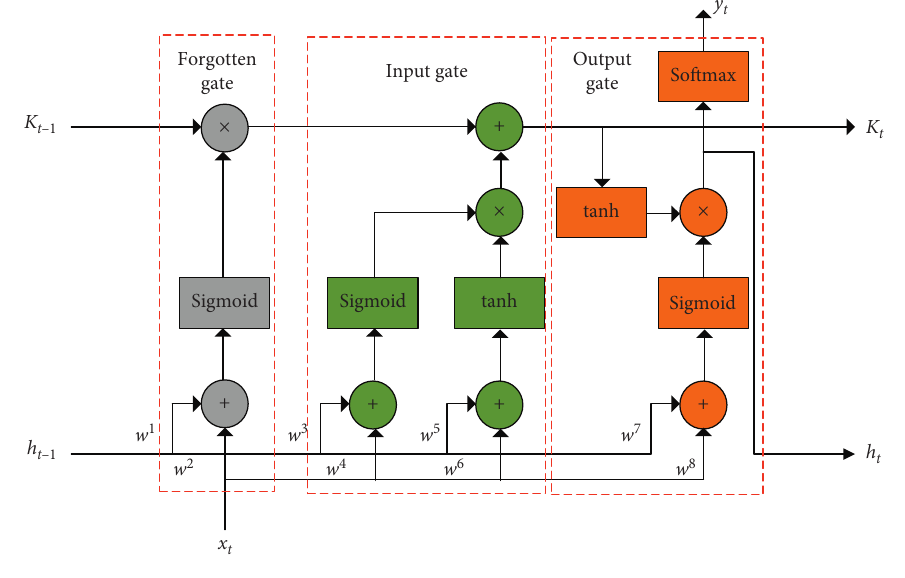
Figure 1: Cell structure of LSTM.